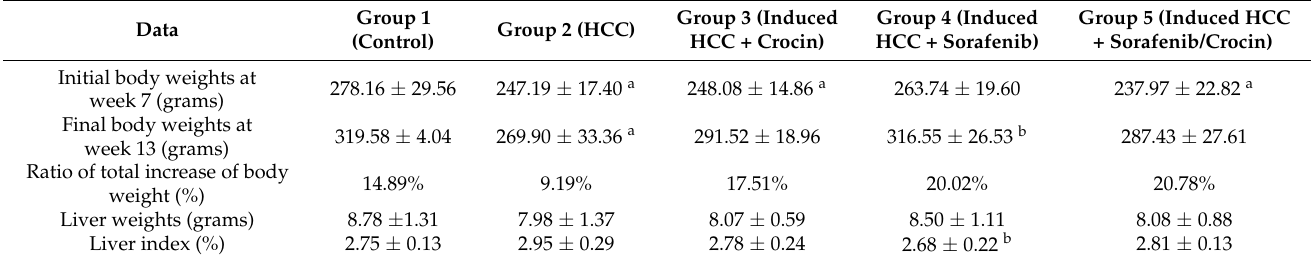
Table 2. Effects of the various treatments on the body and liver weights. Initial and final body weights, changes in body weight, liver weights and liver weight indexes are tabulated in all examined